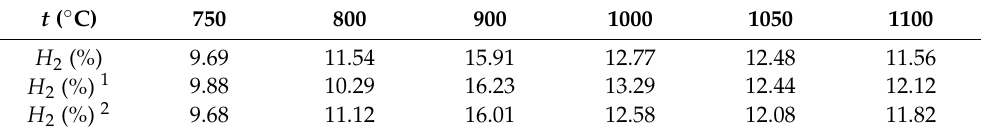
Table 2. Test data for H 2 .